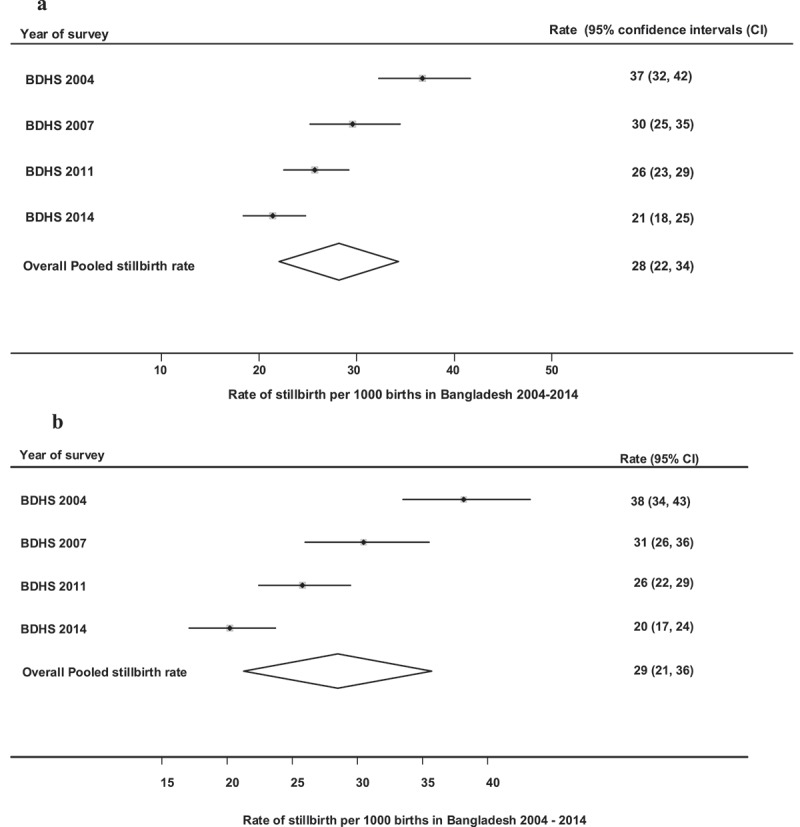
(a) Rate of stillbirth per 1000 births in Bangladesh (with Rangpur), 2004–2014. (b)Rate of stillbirth per 1000 births in Bangladesh (without Rangpur) 2004–2014.